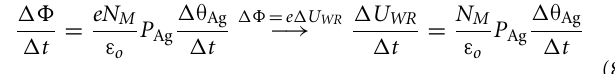
value becomes 4.9 D and also the promotional index is